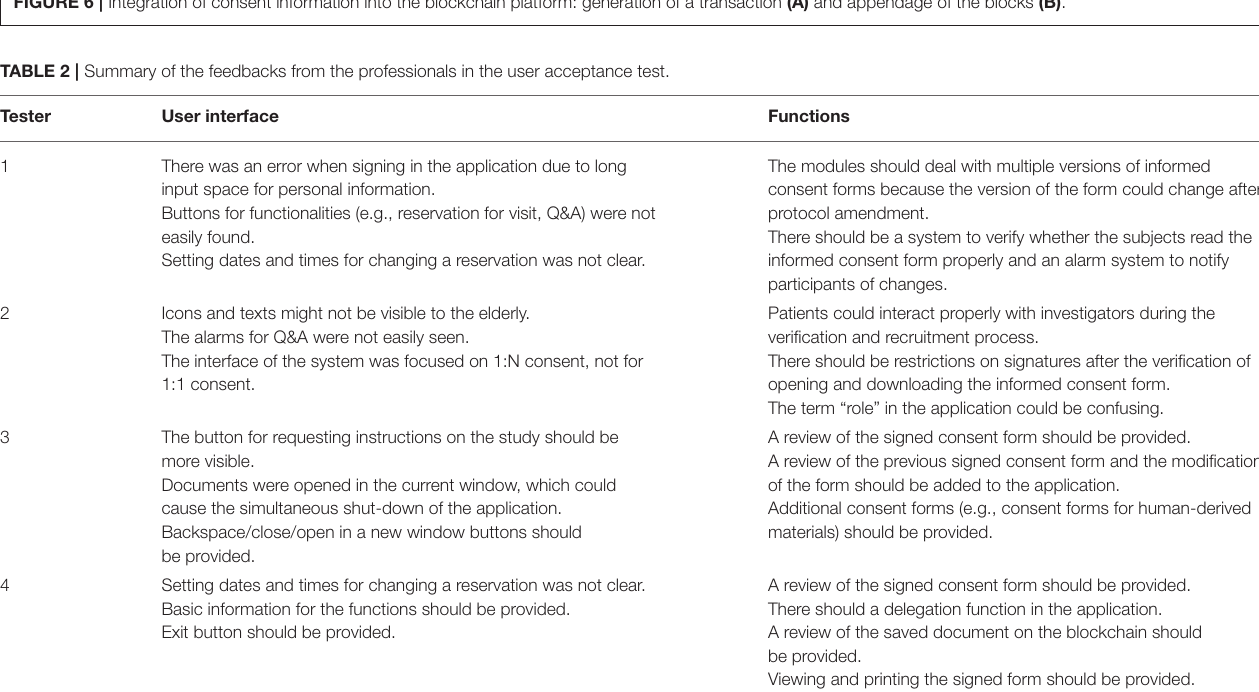
FIGURE 6 | Integration of consent information into the blockchain platform: generation of a transaction (A) and appendage of the blocks (B) .